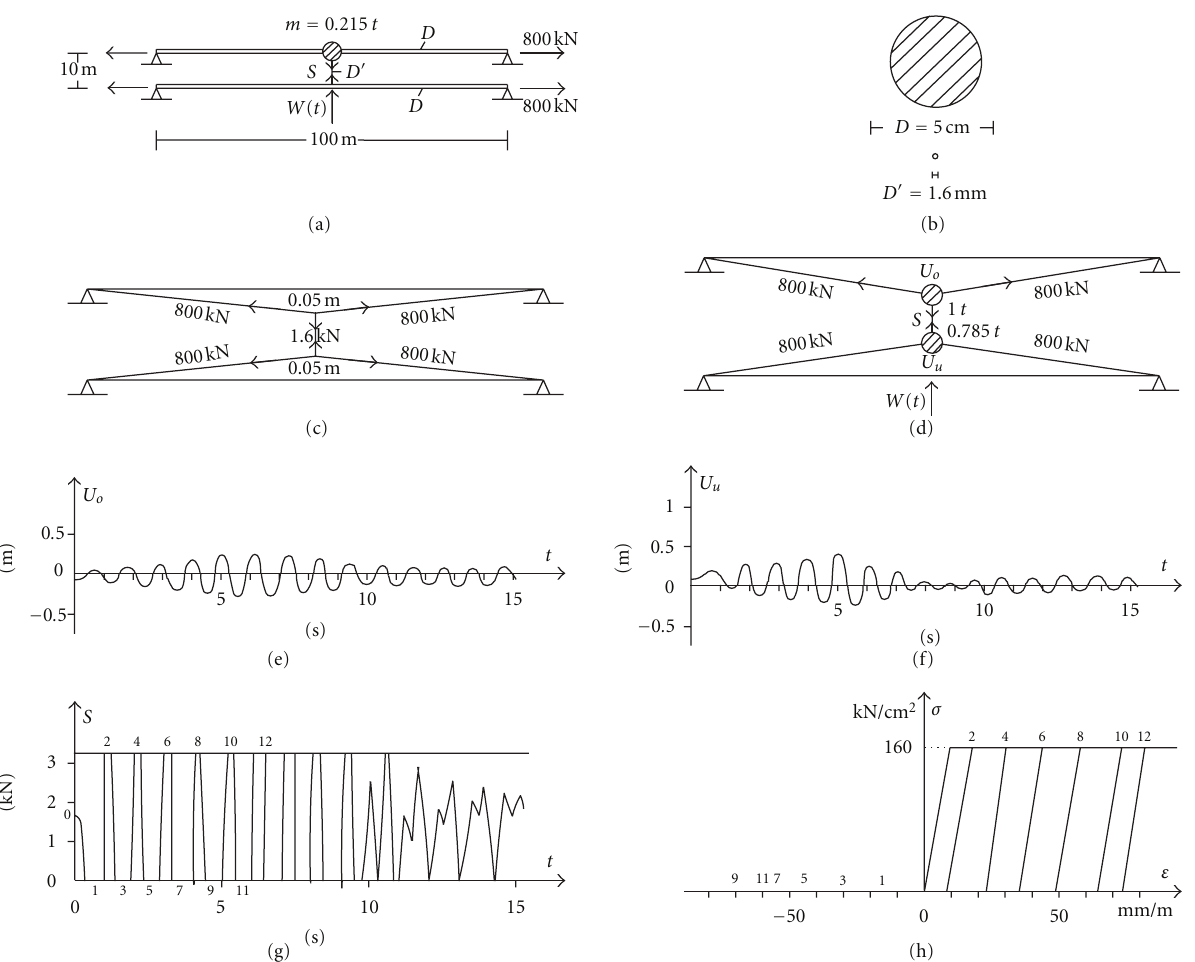
Figure 9: (a) Seventh application: Couple of inter-connected cables subject to wind with additional small mass on one cable. (a) Given geometry, loading and additional small mass. (b) Comparison of cross-sections of cables and cross-tie. (c) Initial static analysis. (d) Parameters of dynamic analysis. (e), (f) Resulting time-histories of displacements of two cables. (g) Resulting time-history of axial force of cross-tie. (h) Resulting hysteresis stress-strain loops of the